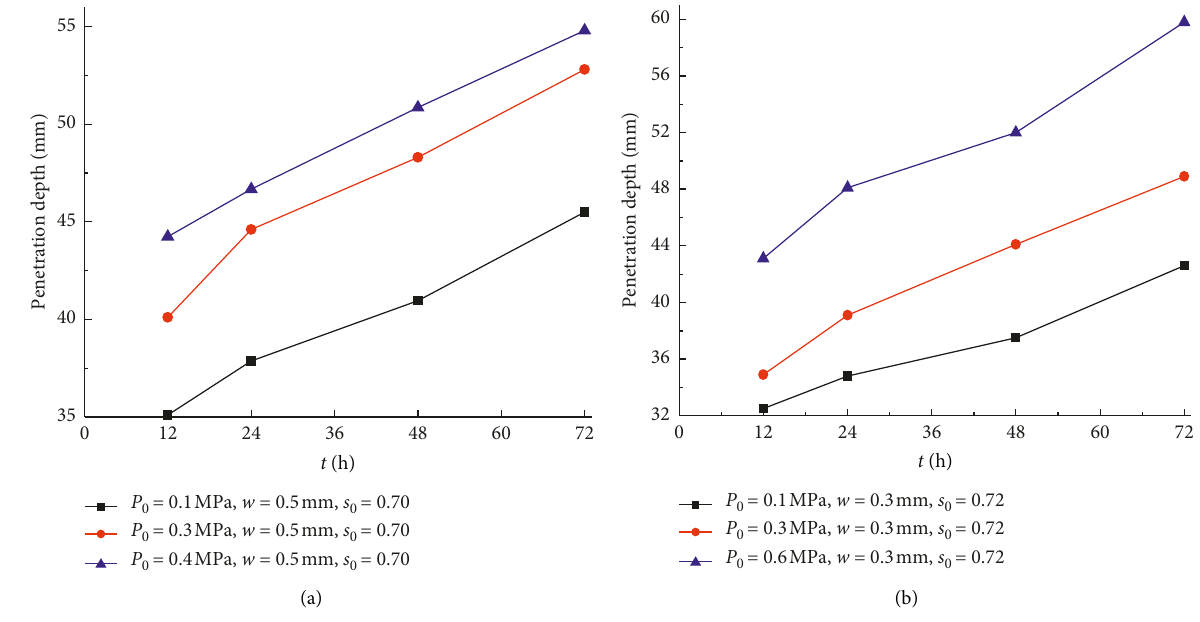
Figure 7: Penetration depth under different hydraulic pressures. (a) BI test blocks. (b) BII test